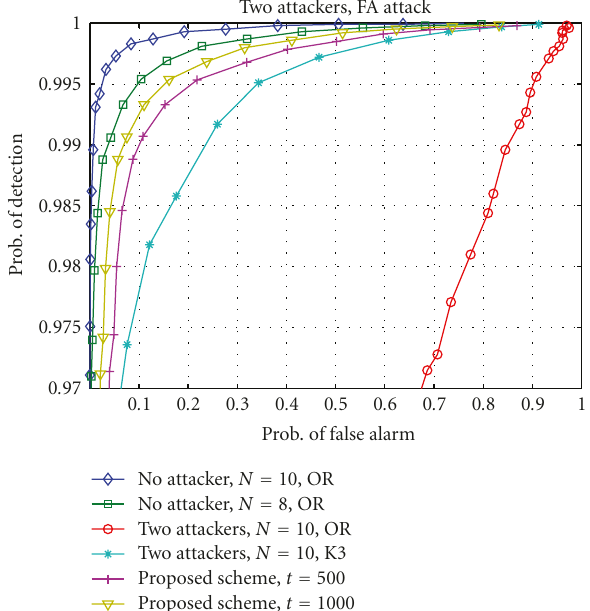
Figure 6: ROC curves (False Alarm Attack, Two Attackers).